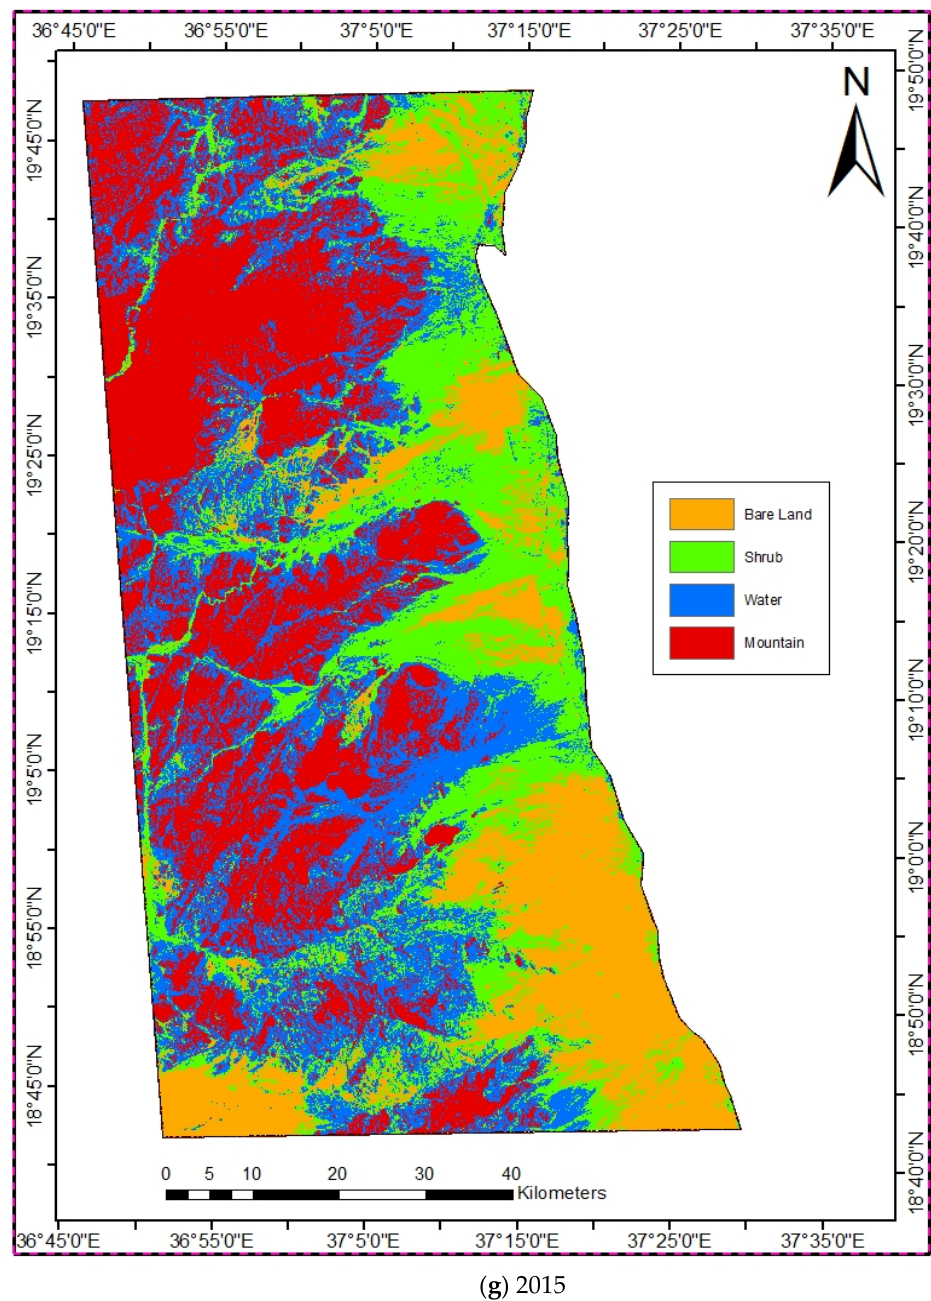
Figure 4. The spatial distribution of bare land, shrubs, water and mountains in the study area for the years ( a ) 1985, ( b ) 1990, ( c ) 1995, ( d ) 2000, ( e ) 2003, ( f ) 2013 and ( g ) 2015.